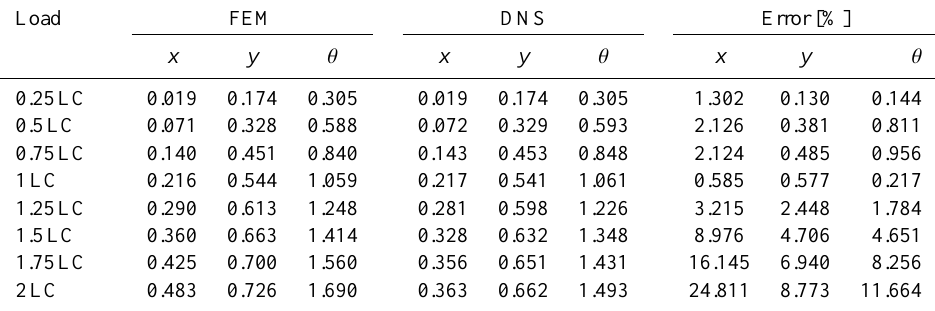
Table 1. Comparison of dimensionless deflections, x [ − ] and y [ − ], and slope, θ [rad], of free end tip from FEM and DNS as the absolute values and relative errors ∗ for the case study; load case (LC) = β = 0 . 663 [ − ], α = 1 . 137 [ − ] corresponds to F w = 73 . 5mN; L w = 14mm; I = 2 . 5 × 10 − 13 mm 4 ; E =